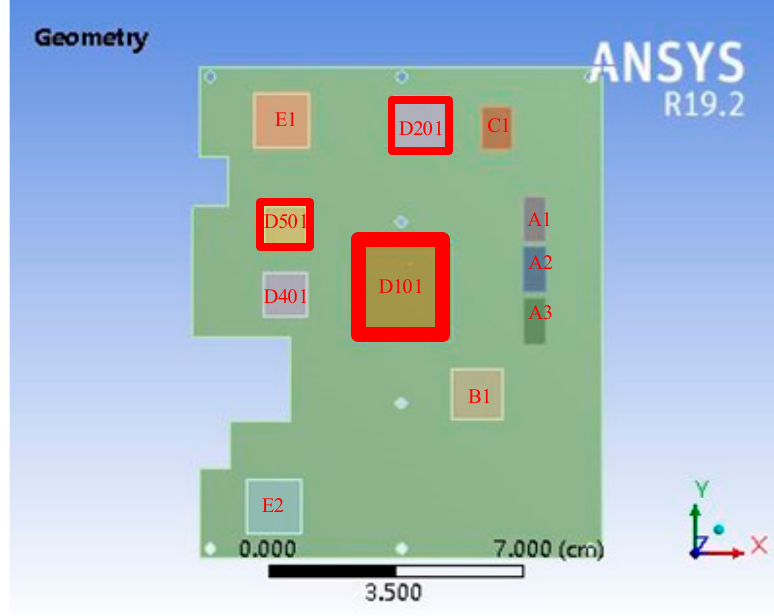
Figure 5. The 3D finite element model.